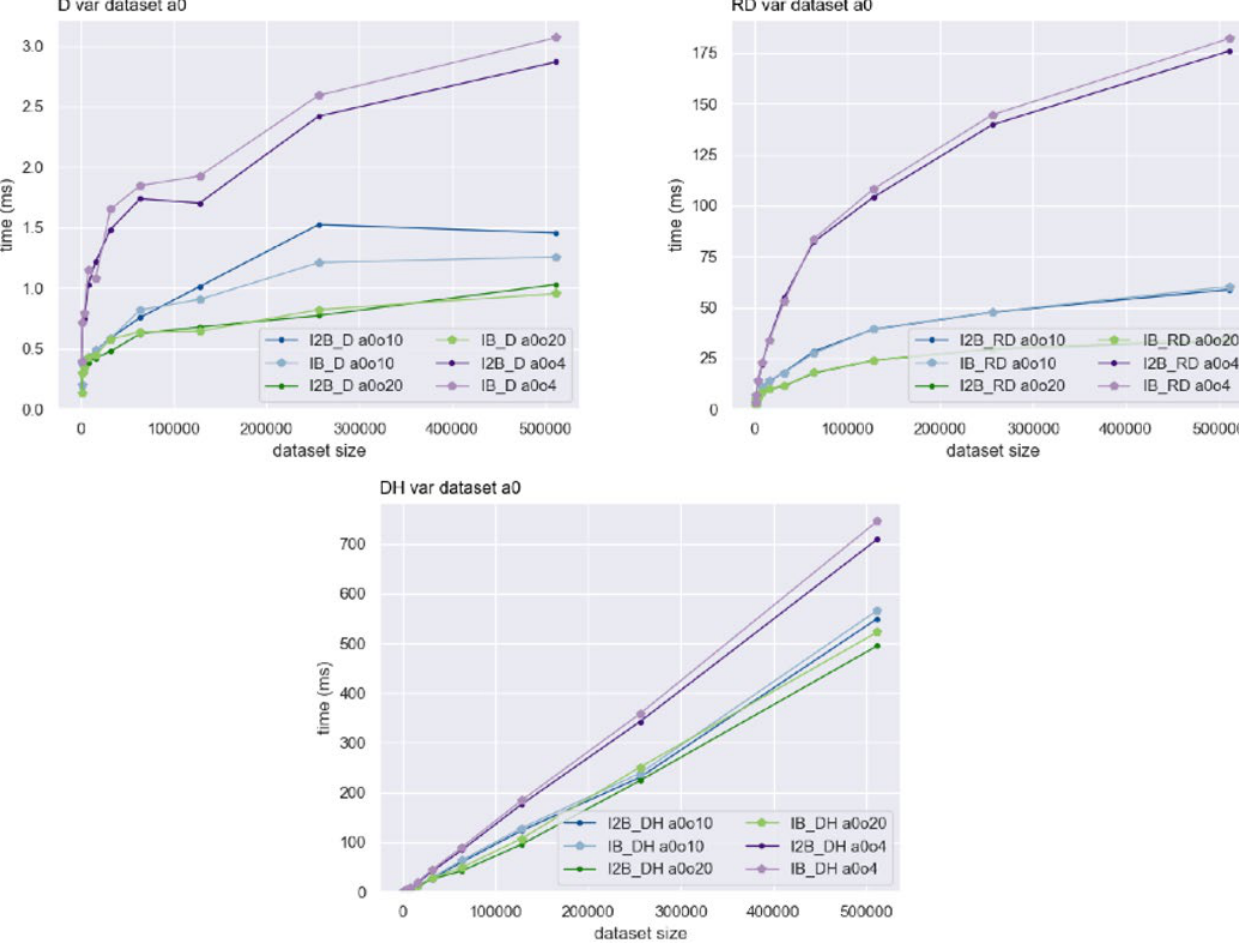
Figure 5. Deletion tests (D, RD and DH), in the big intervals scenario, using an alpha of